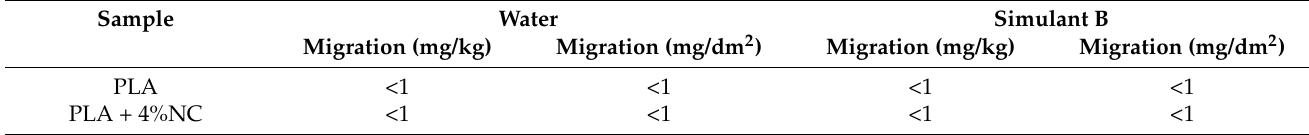
Table 1. Global migration results for PLA and PLA+4%NC in water, used as reference, and simulant B. Sample Water Simulant B Migration (mg/kg) Migration (mg/dm 2 ) Migration (mg/kg) Migration (mg/dm 2 ) PLA <1 <1 <1 <1 PLA + 4%NC <1 <1 <1 <1